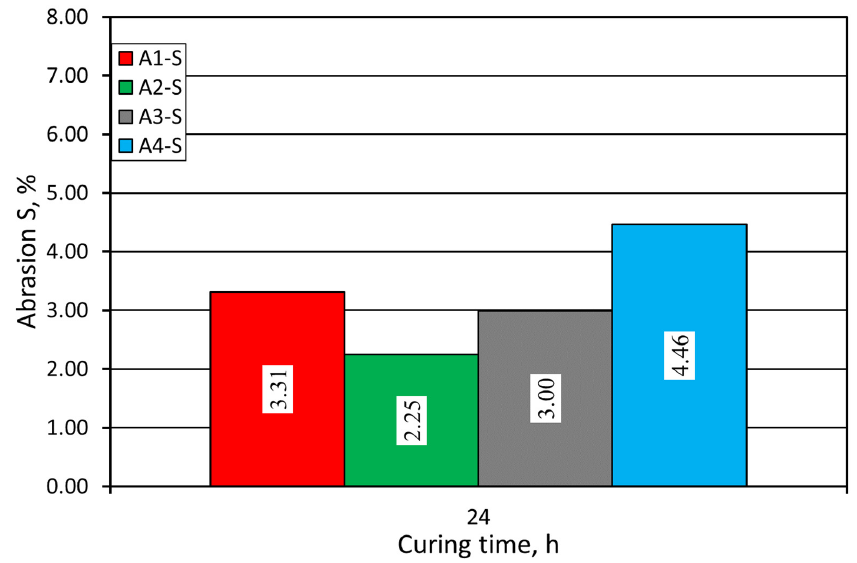
Figure 6. Molding sand S abrasion test carried out on SIBELCO (S) grain matrix.